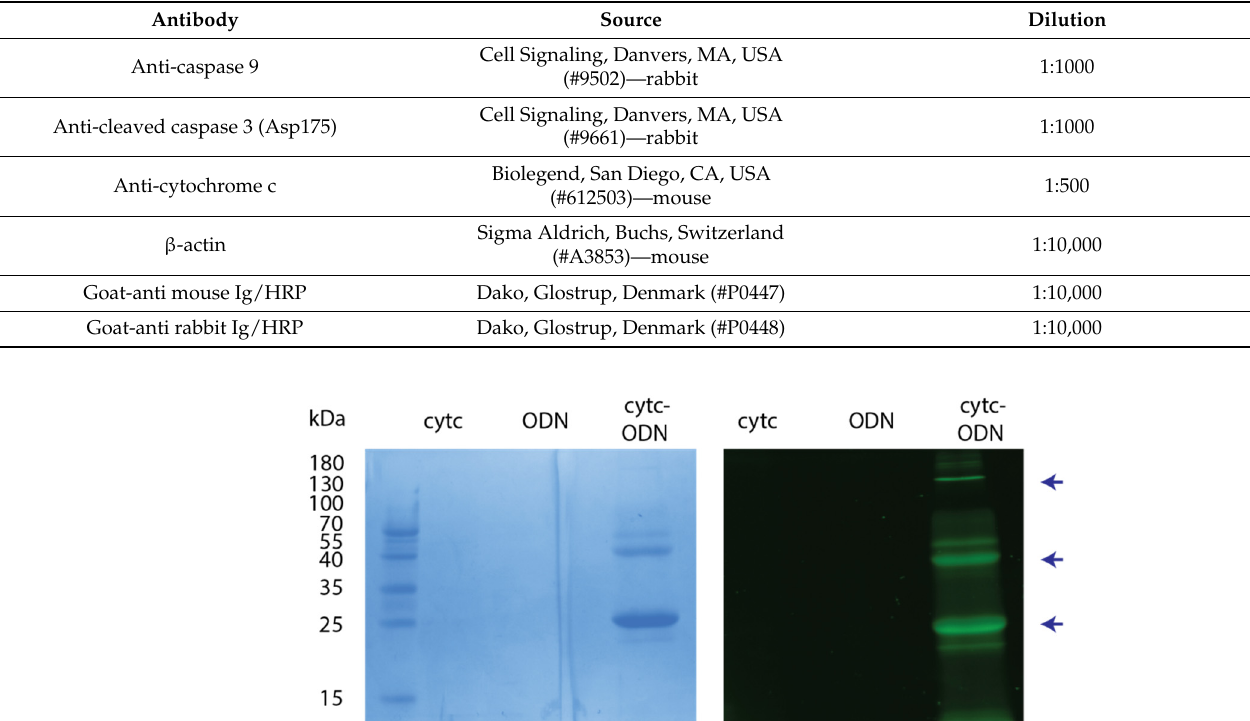
Table A2. Antibodies used in the Western blot analysis.